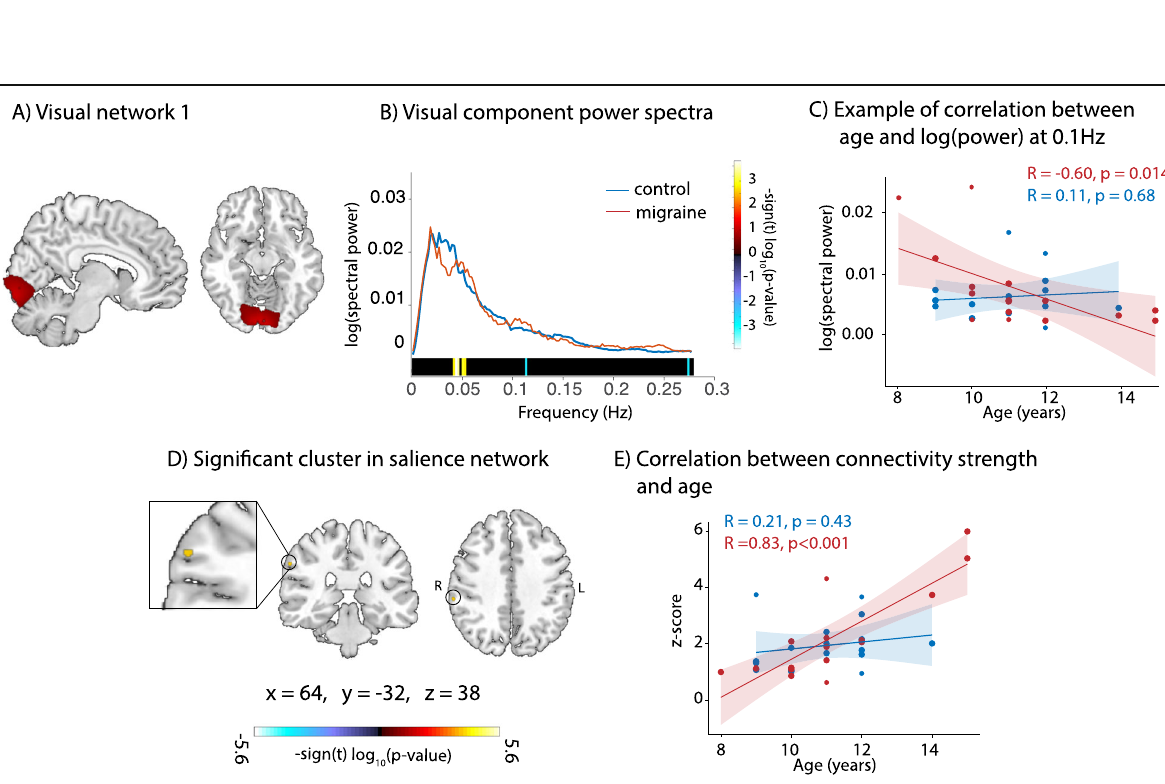
Fig. 2 Group by age interaction effects on connectivity. a Visual network 1. b Power spectra from visual network 1. Frequencies where significant group by age interactions were present are highlighted at the bottom. c Correlation between log (spectral power) and age per group at 0.1 Hz d Cluster in the supramarginal gyrus exhibiting significant group by age interaction effects on connectivity within the salience network (number of voxels= 11) e Correlation between connectivity strength in the supramarginal gyrus and age per group. The migraine group is represented in red and controls in blue for b, c, and